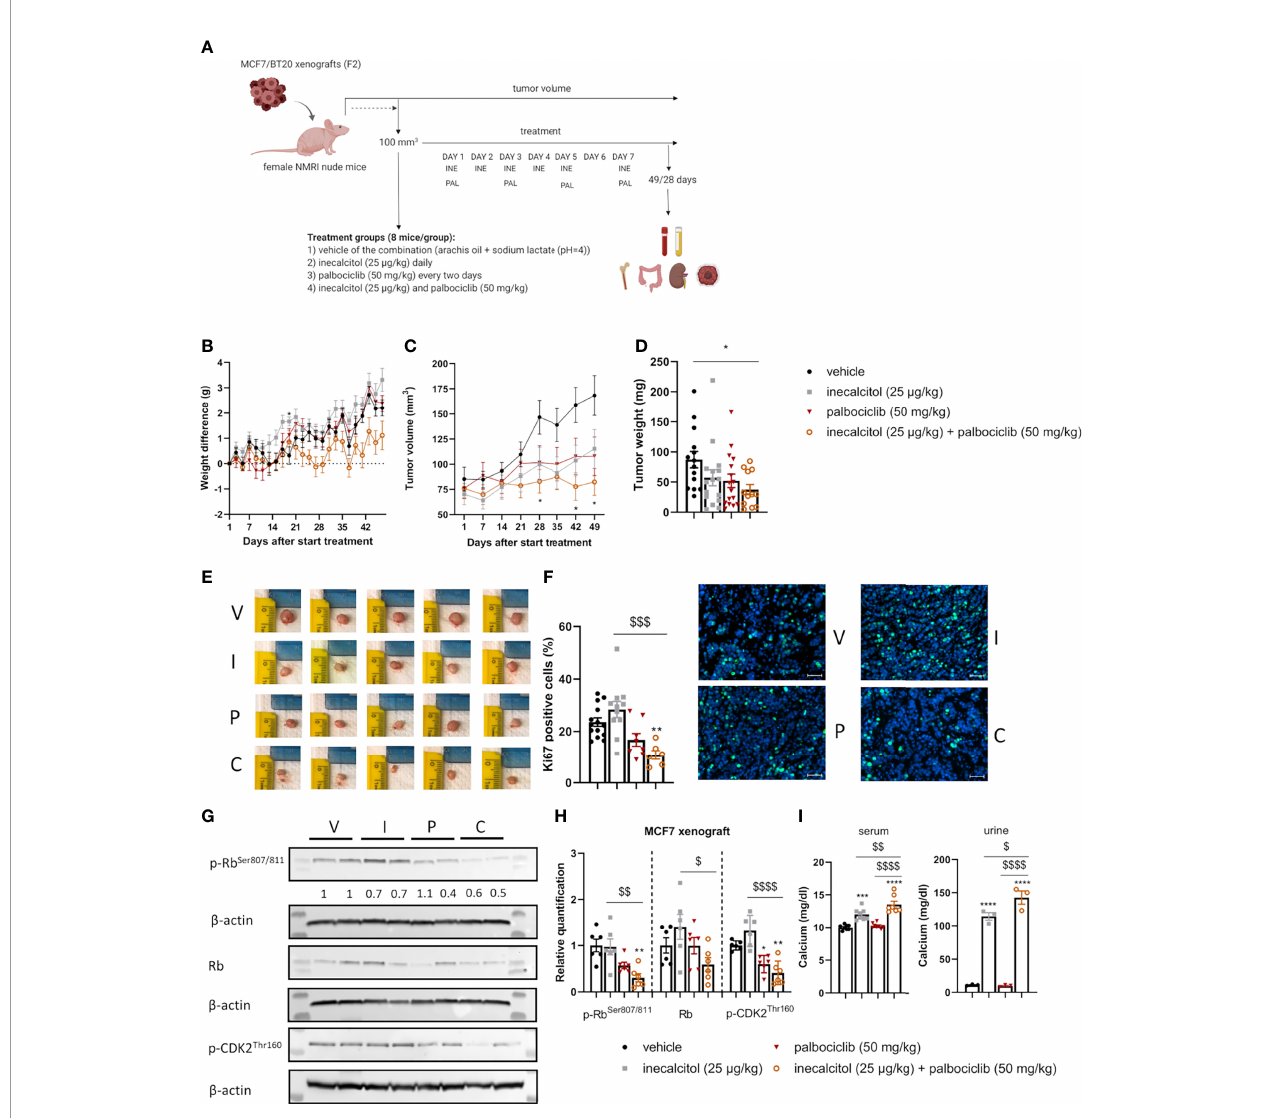
FIGURE 6 | Analysis of the in vivo effect of inecalcitol and palbociclib treatment in an ER + MCF7 xenograft model. (A) Experimental setup of in vivo experiments. Created with BioRender.com. (B) Weight difference compared to start weight during treatment (Mixed effect analysis followed by one-way ANOVA, Sidak ’ s multiple comparison test). (C) Tumor volume during treatment (8 mice/group) (Mixed effect analysis followed by one-way ANOVA, Sidak ’ s multiple comparison test). (D) Tumor weight at day 49 of treatment (12-16 tumors/group). (E) Photographs of tumors isolated at day 49 from the different treatment groups: vehicle (V), inecalcitol (25 µg/kg) (I), palbociclib (50 mg/kg) (P) and combination (C). (F) Immunohistochemistry analysis of Ki67 staining on tumor samples (6-14 tumors/group) and representative pictures of Ki67 staining (green) with DAPI counter staining (blue) per group: vehicle (V), inecalcitol (25 µg/kg) (I) , palbociclib (50 mg/kg) (P) and combination (C). Scale bar = 50 µm. (G) P- Rb, total Rb (110 kDa) and p-CDK2 (33 kDa) protein expression in tumors from vehicle (V), inecalcitol (25 µg/kg) (I) , palbociclib (50 mg/kg) (P) and combination (C) treated mice (6 tumors/group). One representative blot is shown. b -actin (42 kDa) was used as loading control. The ratio of phosphorylated to non-phosphorylated relative protein expression is indicated under the representative blot. Data are expressed as fold increase vs control (control value = 1). (H) Relative quanti fi cation of p-Rb, total Rb and p-CDK2 protein expression (n=6 tumors/group). Data shown as mean ± SD. (I) Calcium analysis of serum (7-8 mice/group) and urine (3 pooled samples/group). Data shown as mean ± SEM of one experiment (8 mice/group). *p ≤ 0.05; **p ≤ 0.01; ***p ≤ 0.001; ****p ≤ 0.0001 compared to vehicle; $ p ≤ 0.05; $$ p ≤ 0.01; $$$ p ≤ 0.001; $$$$ p ≤ 0.0001 compared to inecalcitol or palbociclib monotherapy (one-way ANOVA, Sidak ’ s multiple comparison